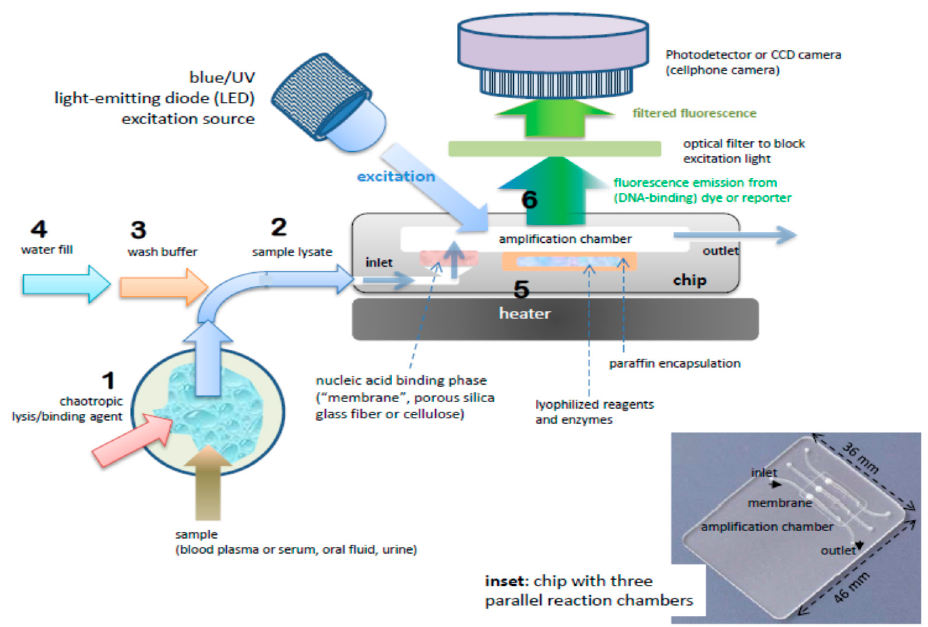
Figure 2. Process steps and (cross-section) schematic of chip for nucleic acid amplification test (NAAT). Chip has one or more flow-through chambers for isothermal amplification and includes a filter-like, flow-porous nucleic acid binding phase (e.g., silica glass fiber or cellulose) and is pre-loaded with paraffin-encapsulated amplification reagents (lyophilized polymerase, primers, fluorescence reporter DNA-intercalating, dyes, and other components). Operational steps: (1) sample is mixed off-chip with lysis/binding reagent buffer (containing e.g., chaotropic agent such as guanidinium HCl) that lyses virus and cells and promotes nucleic acid adsorption to binding media, e.g., silica glass fiber or cellulose (‘membrane’), (2) sample (~100 µ L) is injected into chip with pipette or syringe, (3) ethanol-based, high-salt buffer (~100 µ L) is injected into chip to wash the membrane (keeping most of the captured nucleic acid adsorbed to the membrane, (4) chamber (25 to 50 µ L volume) is filled with water and sealed with tape, (5) chip is heated to amplification temperature (~65 ◦ C) using a small (~1 Watt) electric-heater. The heating melts the paraffin encapsulation, releasing and reconstituting the reagents, (6) the amplification reaction is excited with a blue or UV LED, such that the DNA intercalating dye generates a fluorescence signal proportional to the amount of DNA amplicon produced. The fluorescence is measured by filtering the excitation light and detection with a photodetector of CCD camera, such as provided by a mounted